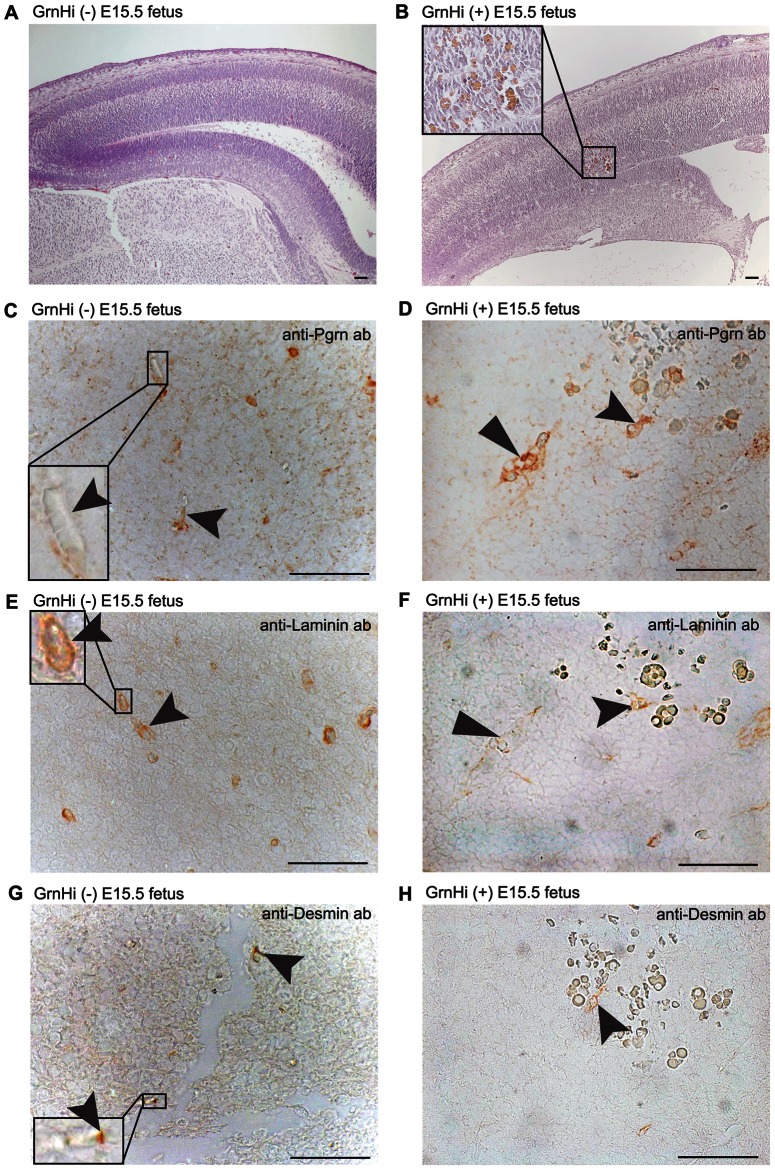
Cerbrocortical hemorrhaging in Tie2-Grn positive fetus at E15.5 associated with reduced basement membrane and pericyte enclosure of capillaries.H&E staining of the cerebral cortex of (A) a Tie2-Grn negative fetus with no hemorrhage sites and (B) a Tie2-Grn positive fetus. Small localized hemorrhages were observed in the cerebral cortex of the Tie2-Grn positive fetus (insert) but not the Tie2-Grn negative fetus. Capillaries (black arrow heads) were poorly stained for progranulin in the Tie2-Grn negative fetus (C), but displayed high levels of progranulin in the Tie2-Grn positive fetus (D). The basement membrane protein laminin clearly demarcated capillaries in the Tie2-Grn negative fetus (E, and insert). Some capillaries in the Tie2-Grn positive fetus showed strong laminin staining (tailed arrowhead) while other showed reduced laminin (flat arrowhead). Desmin, a marker for pericytes, was associated with capillaries in the Tie2-Grn negative fetus (F, and insert). Few capillaries in the Tie2-Grn positive were positive for desmin (arrowhead).